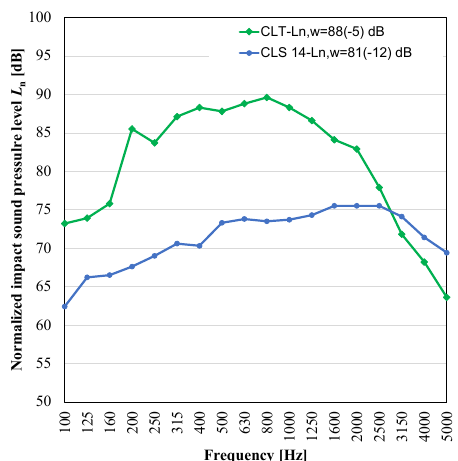
Figure 8. Normalized impact sound pressure level for CLT floor (200 mm) and for concrete floor (140 mm).